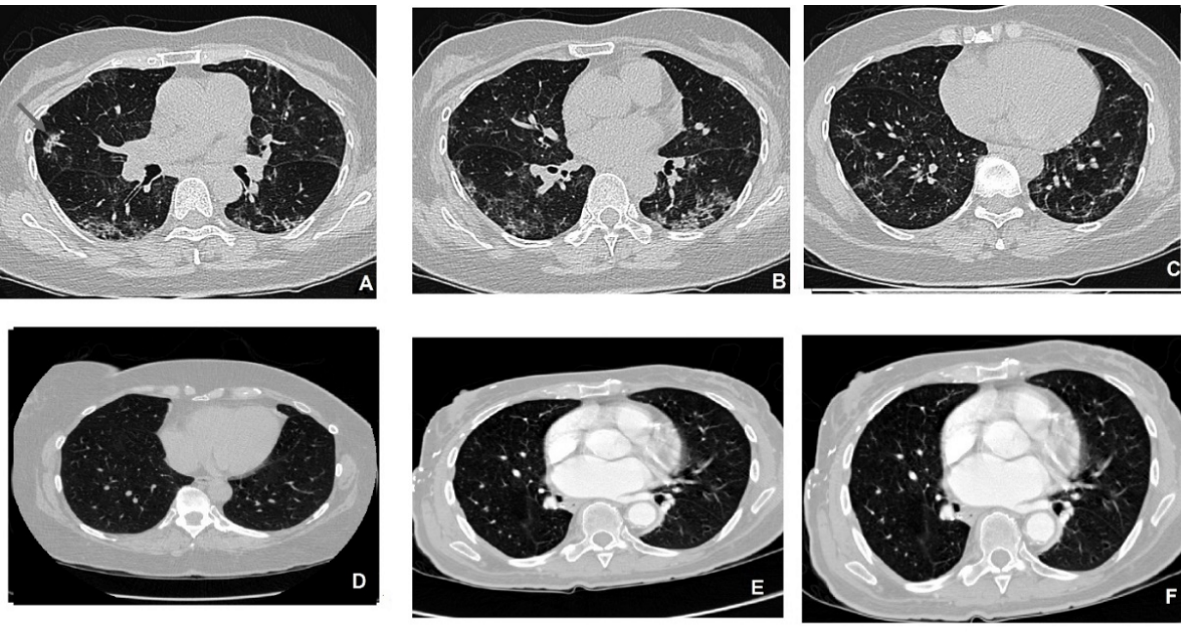
Figure 1. Axial computed tomography scan slices of the lung. (A, B, C) Non–COVID-19 cases including those of pneumonia and healthy individuals; (D, E, F) infected lungs of patients with